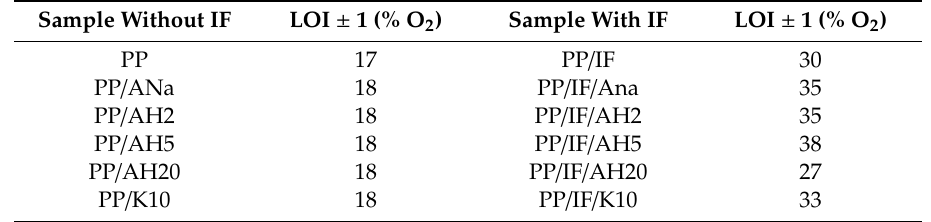
Table 6. Limit oxygen index (LOI) results for samples with and without intumescent formulation. Sample Without IF LOI ± 1 (% O 2 ) Sample With IF LOI ± 1 (% O 2 )